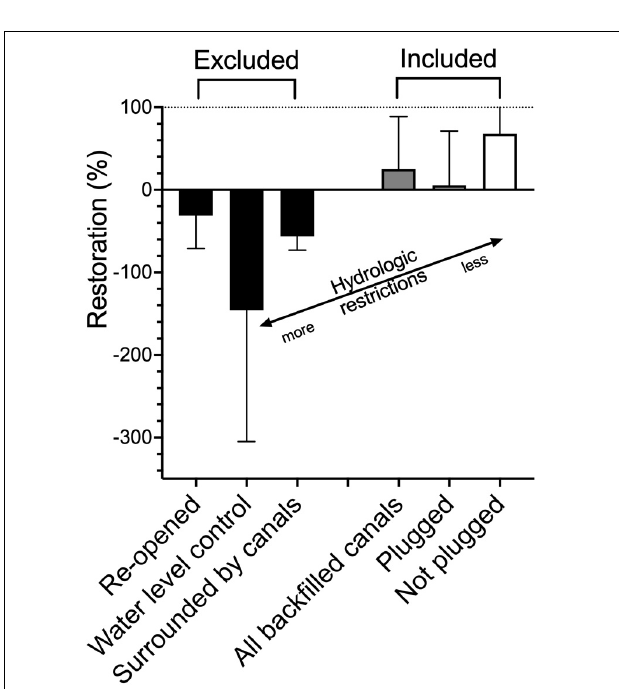
FIGURE 6 | A summary of the percent wetland restoration of open water in the Group 1 backfilled canals after 39 years. The excluded sites had mostly no restoration, and the average was negative. The wetland restoration in the plugged canals was significantly lower than in canals without a fully closed plug after